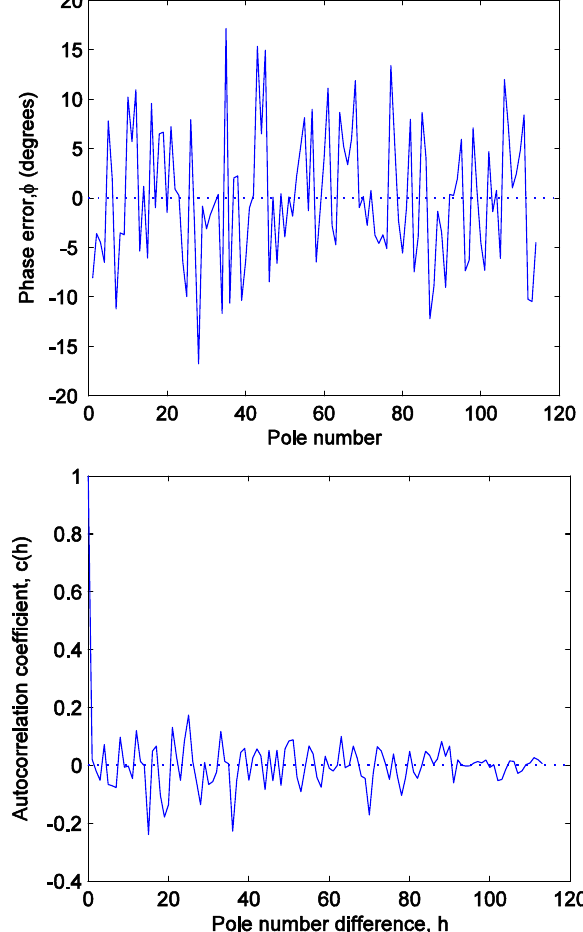
FIG. 1. Phase errors (upper) and corresponding autocorrelation coefficients (lower) for a set of random phase errors with rms ¼ 6 : 7 (cid:2) value of (cid:1) ’